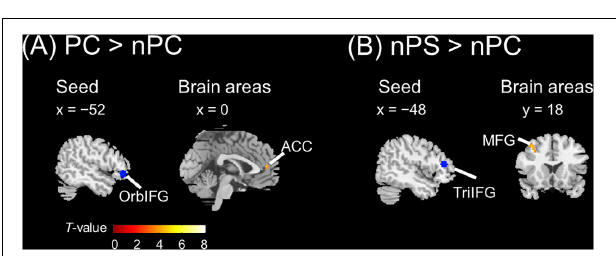
FIGURE 5 | Correlations between neural activities of the overlapping left TriIFG and target recognition accuracy under a − 4 dB SMR in behavioral testing. (A) Contrast values of the ASP effect under the perceived separation condition (“PS > nPS” contrast) were correlated with the corresponding contrasts of recognition accuracy. (B) Contrast values of the spatial unmasking effect under the ASP condition (“PS > PC” contrast) were correlated with the corresponding contrasts of recognition accuracy. The shades represent 95% confidence intervals.